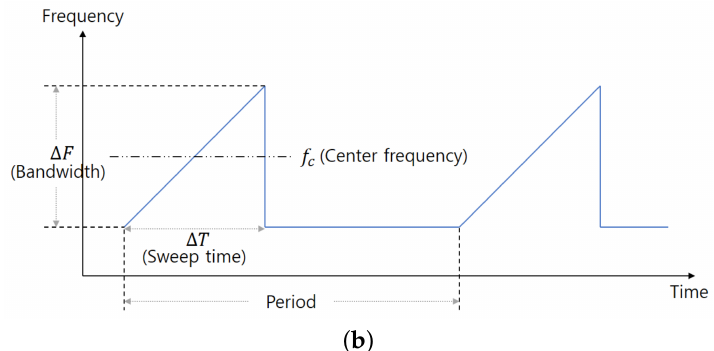
Figure 2. FMCW RADAR ( a ) structure ( b ) signal produced from the waveform-generator